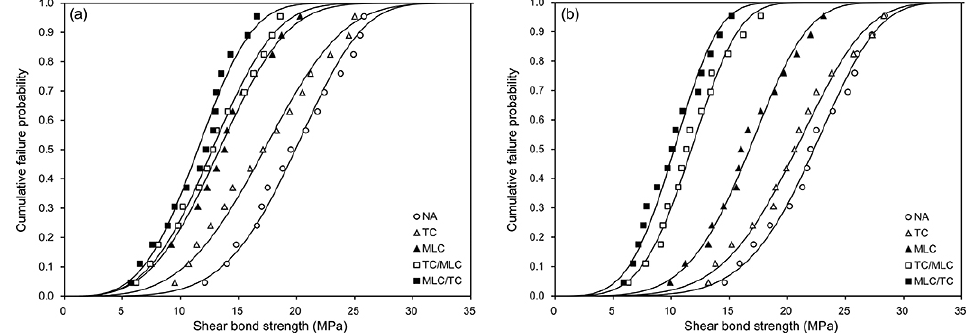
Figure 2. Weibull cumulative failure probability curves for the shear bond strength (SBS) values: ( a ) Panavia F2.0 and ( b ) RelyX U200.